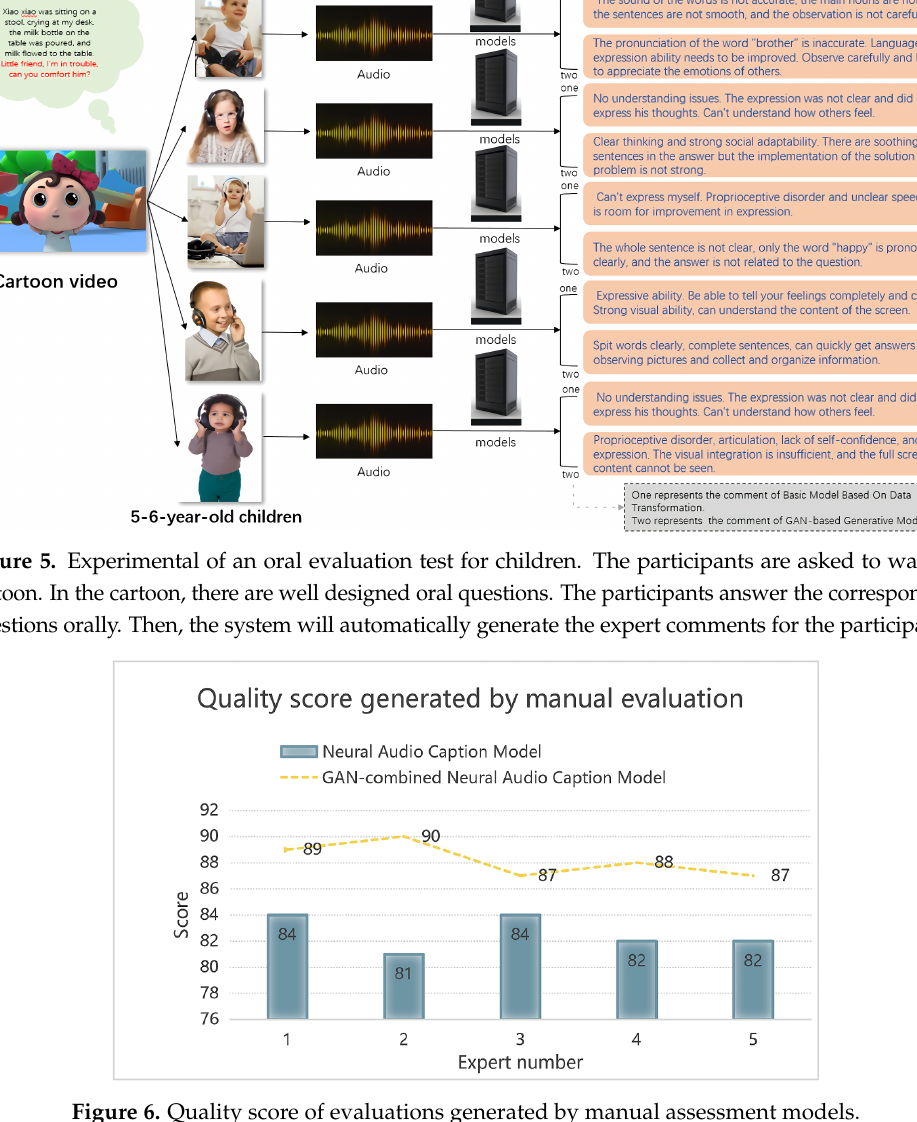
Figure 6. Quality score of evaluations generated by manual assessment models.